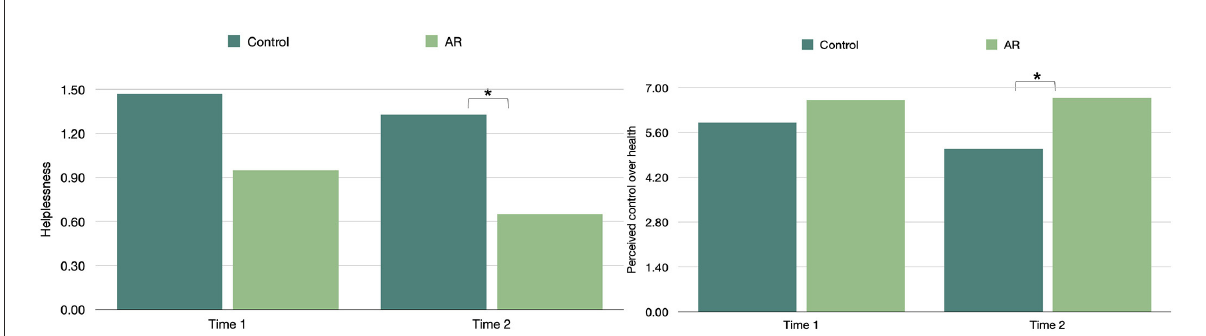
FIGURE1 Attributional Retraining (AR) treatment differences in control-related outcomes at Time 1 and Time 2. In the sample of older adults attending a day hospital, pre- and post-treatment differences are presented between the AR ( n = 18) and No-AR ( n = 19) participants. Findings revealed AR (vs. no-AR) recipients reported significantly lower helplessness and greater perceived control over health at Time 2. Although the Time 1 helplessness means appear to differ in the figure, the difference was not